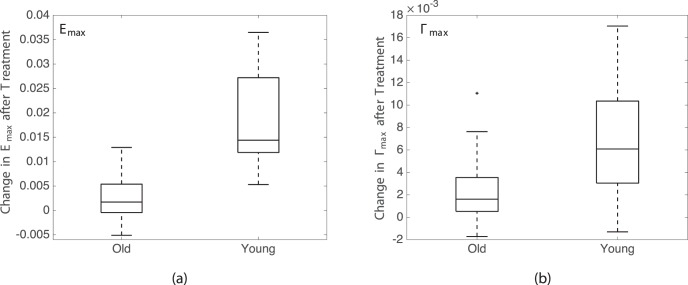
Comparison of the decrease in the strain magnitudes at 45 mm Hg after sGAG degradation in the LC of middle-aged and older-aged donor eyes: (a) Emax and (b) Γmax.